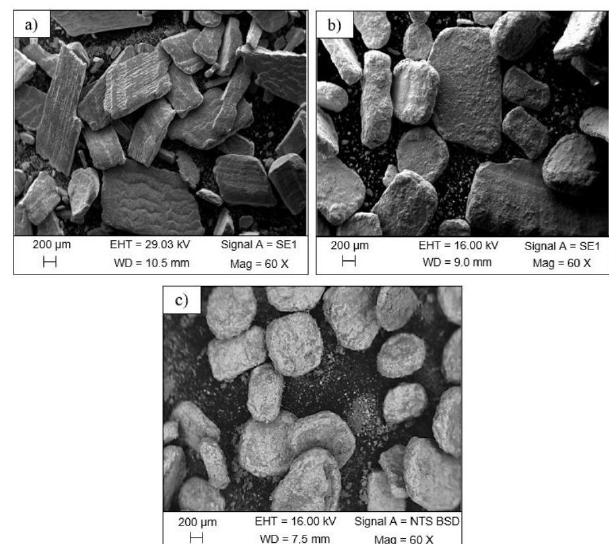
Figure 1: SEM micrographs of the Vanadis ® 8 steel without carbides addition and milled for: (a) 4 hours (b) 8 hours (c) 12